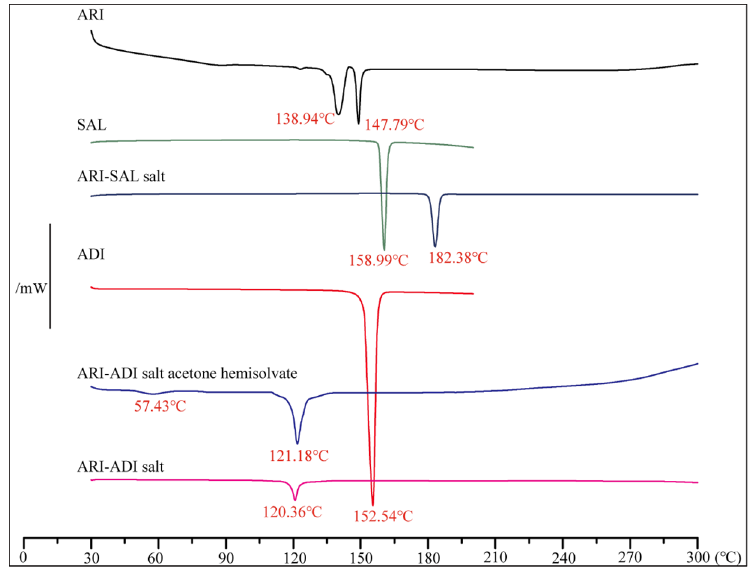
Figure 5. DSC thermograms of ARI, CCF, and its crystal salts.